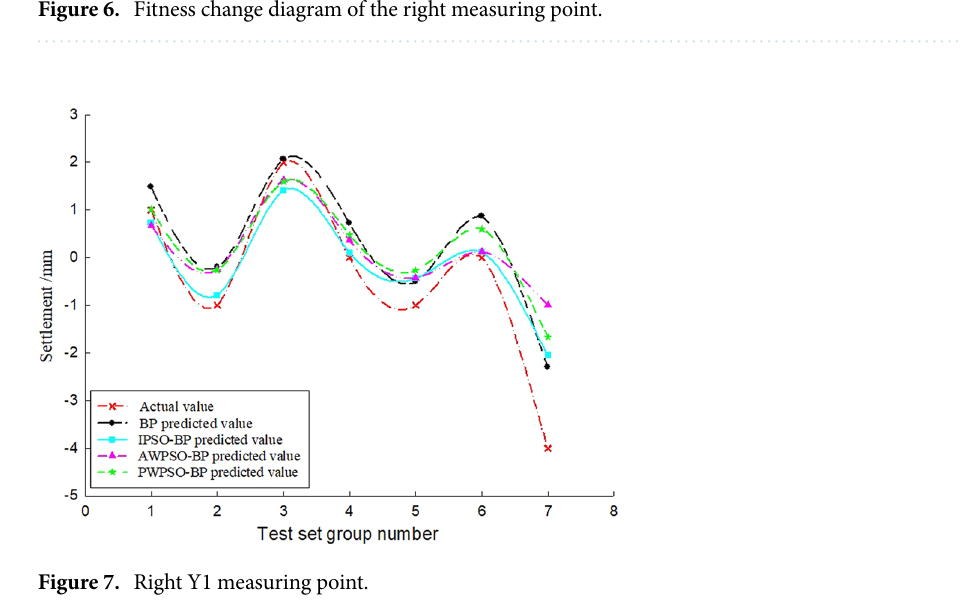
Figure 6. Fitness change diagram of the right measuring point.